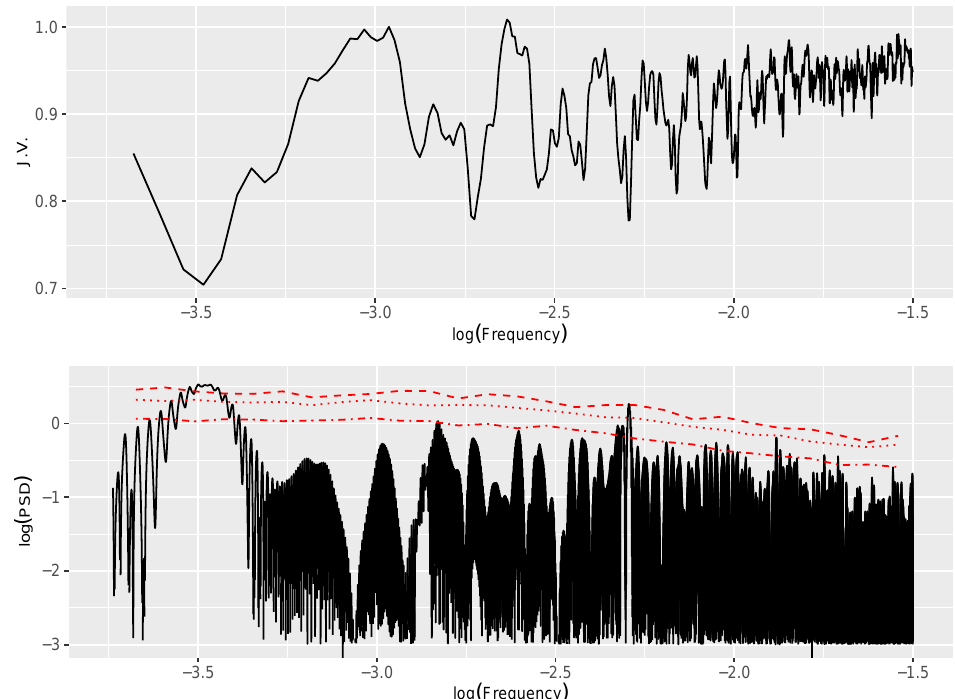
Figure 2. Top panel: Periodicity analysis results of AO 0235+164 obtained by Jurkevich (JV) method. Bottom panel: results for AO 0235+164 by power spectral analysis (PSA) method. The curves of the false alarm probability by using the continuous autoregressive process (CAR1) method are also plotted. Two signals, P 1 = 8.26 yr and P 2 = 0.54 yr, can be found with the threshold that false alarm probability ( FAP ) ≥ 3 σ